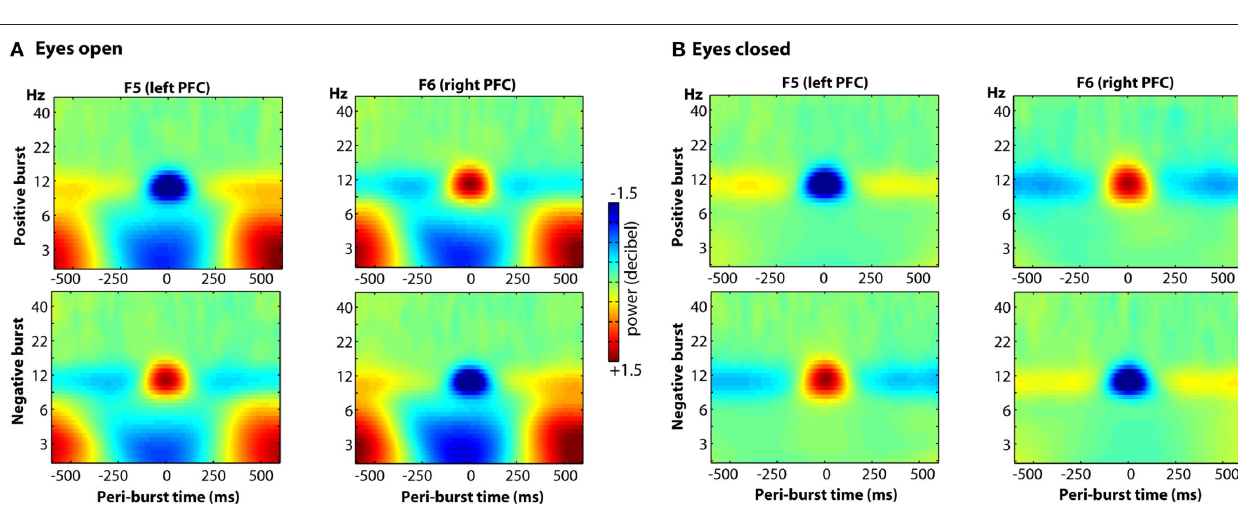
FIGuRE 14 | The oscillatory dynamics of a wider frequency range for sites F5 and F6, as a function of positive and negative bursts, depicted separately for eyes-open and eyes-closed epochs. Clear alpha modulation surrounds each burst, with F5 and F6 revealing effects of similar size but